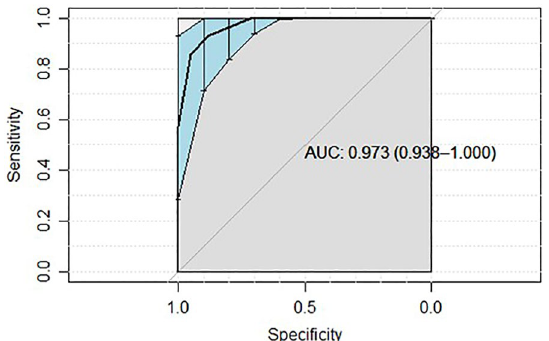
Fig. 5 ROC curve. The area under the ROC curve (AUC) was 0.973. From the analysis of the cut-off points, it is observed that a value of 5.7 mm of ONSD maximizes the sensitivity (92.9%) of the method (a greater number of individuals with ICP > 20 mmHg are correctly identified) with a specificity of